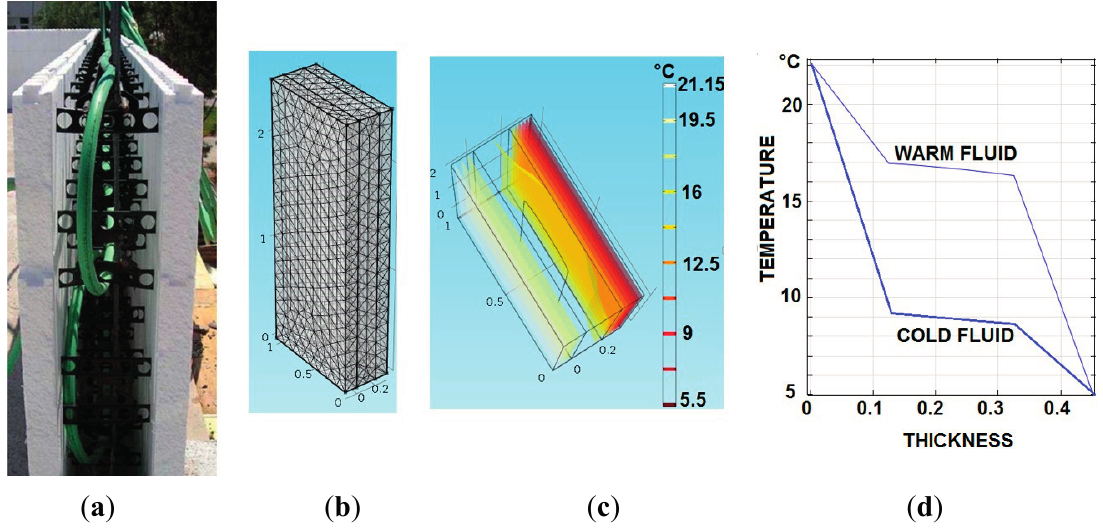
Figure 5. ( a ) PP pipes between two insulation layers of the wall; ( b ) Simulation of the finite elements wall model; ( c ) Wall isothermal distribution; ( d ) Temperature vs